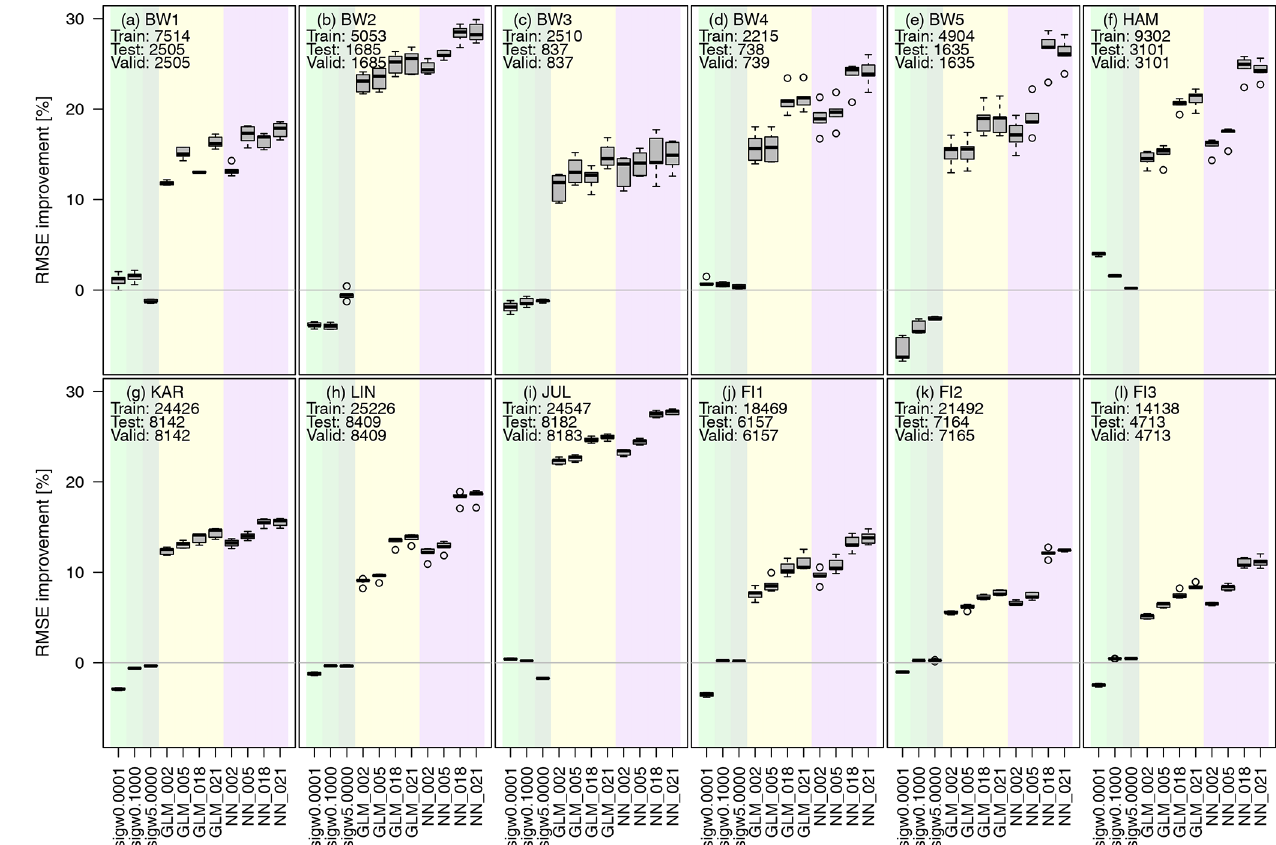
Figure 4. The plot shows the change in RMSE compared to COSMO-REA6 for all 12 observation sites with positive values indicating an improvement over the reanalysis. Light green, green and dark green boxplots show the improvement against the COSMO-REA6 from the diagnostic wind model with σ w = 0 . 0001, σ w = 0 . 1000 and σ w = 5 . 000. Yellow and purple boxplots indicate the improvement for the GLMs and ANNs, respectively. Each boxplot represents five estimated models obtained by randomly splitting the data set into training, validation and testing. The numbers on the x axis (2, 5, 18, 21) show the number of input variables for each model. Positive percentages represent an improvement regarding the RMSE against COSMO-REA6. Numbers inside the panels show the sample sizes used for training, testing and validation at each observation